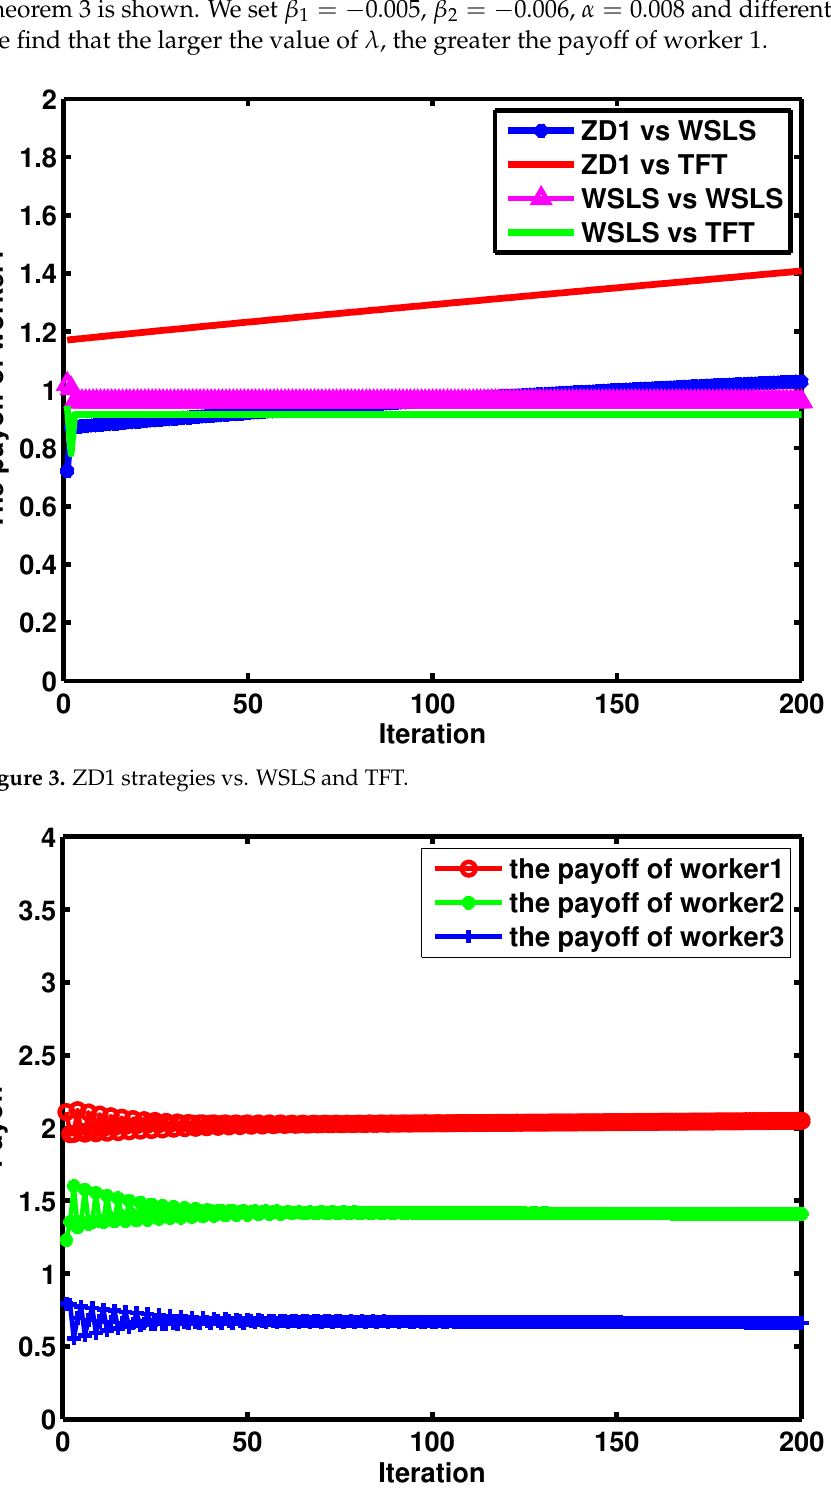
Figure 4. The payoff of 3 workers where worker 1 uses the ZD2